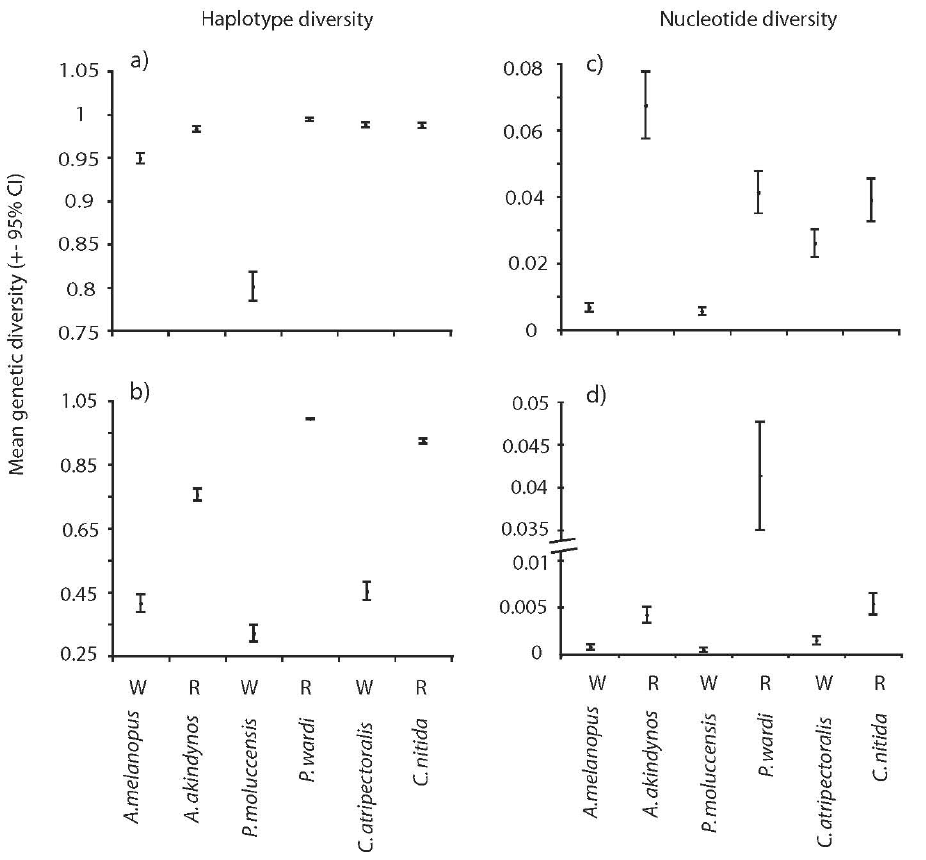
Figure 1. Haplotype diversity (mean ± 95% confidence intervals) based on (a) transitions and transversions and (b) transversions alone, nucleotide diversity (mean ± 95% confidence intervals) based on (c) transitions and transversions and (d) transversions alone in the three widespread (W) and spatially restricted (R) species.